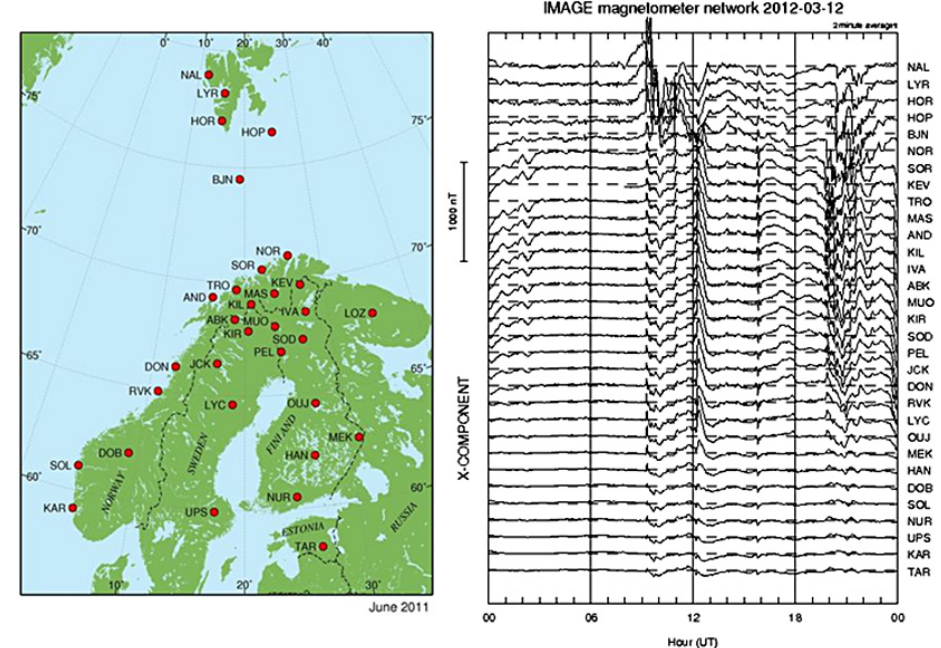
Figure 10. The X-components (northward components) of the geomagnetic field obtained from the IMAGE magnetometer network observa- tions on 12 March 2012 (right panel). The geographic/geomagnetic latitude region from 78.92 ◦ /75.25 ◦ (Ny-Ålesund: NAL) to 58.26 ◦ /54.47 ◦ (Tartu: TAR) is covered by the IMAGE network (the station map is shown in the left panel). LYR and TRO in the panels indicate Longyear- byen and Tromsø,